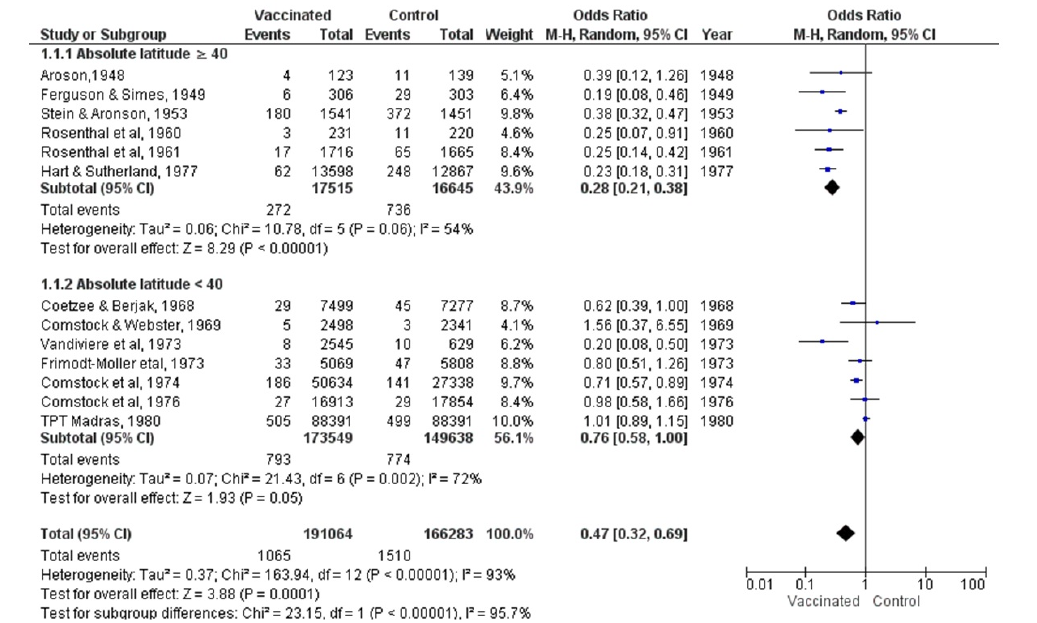
Figure 3. Random-effects Forest